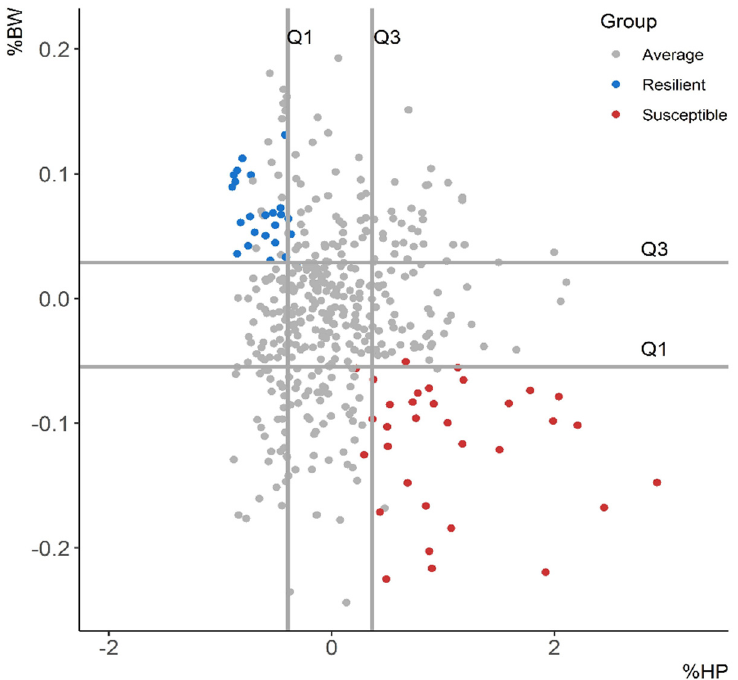
Figure 3. Projection of the resilient, average, and susceptible groups obtained with the first (Q 1 ) and